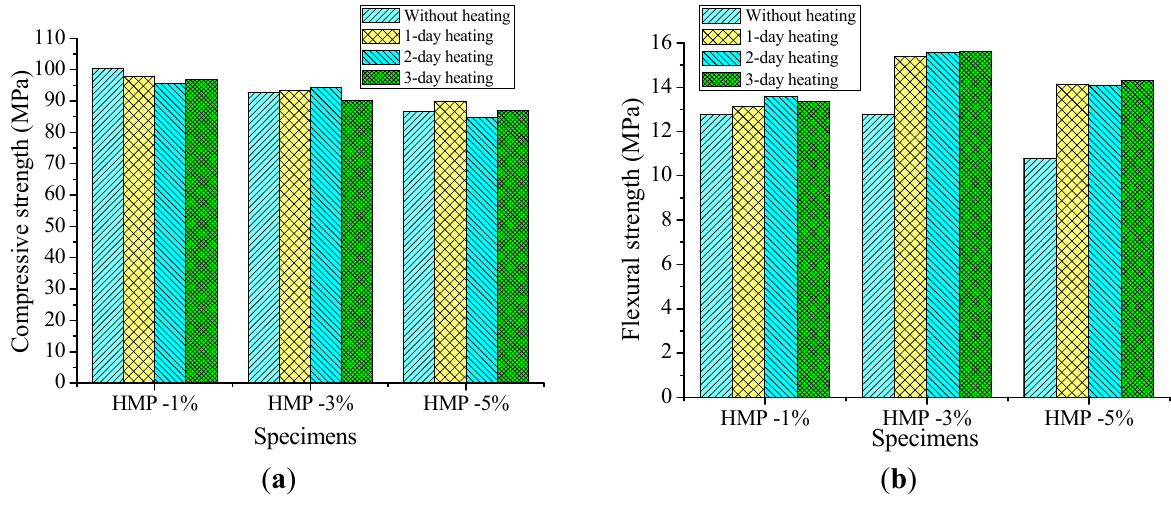
Figure 8. ( a ) The compressive strength of HMP mortars after heat treatment. ( b ) The flexural strength of HMP mortars after heat